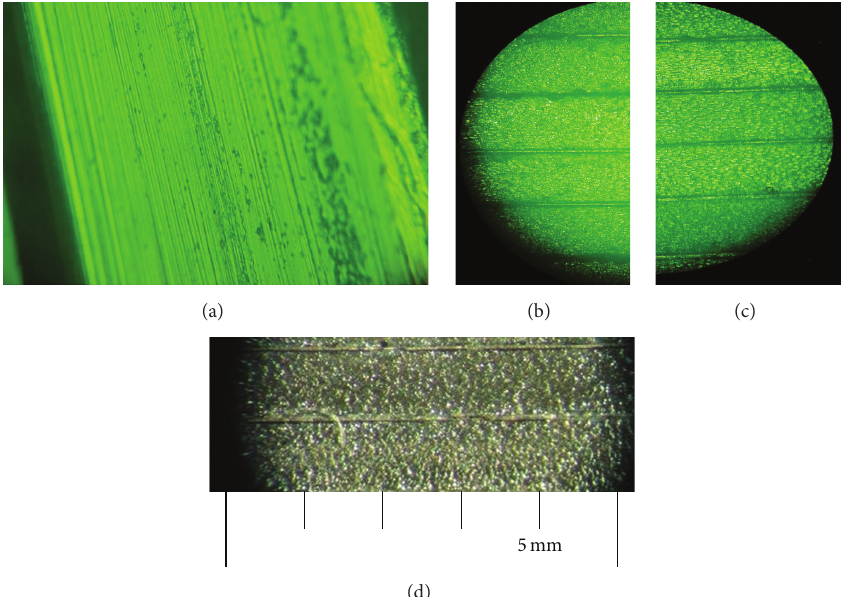
Figure 2: Images of the surface of Si-SC with VA p-n junction under 500x magnification. (a) after mechanical processing; (b) after RF treatments; (c) after RF treatments and DLCF coating; and (d) surface patterns of module.